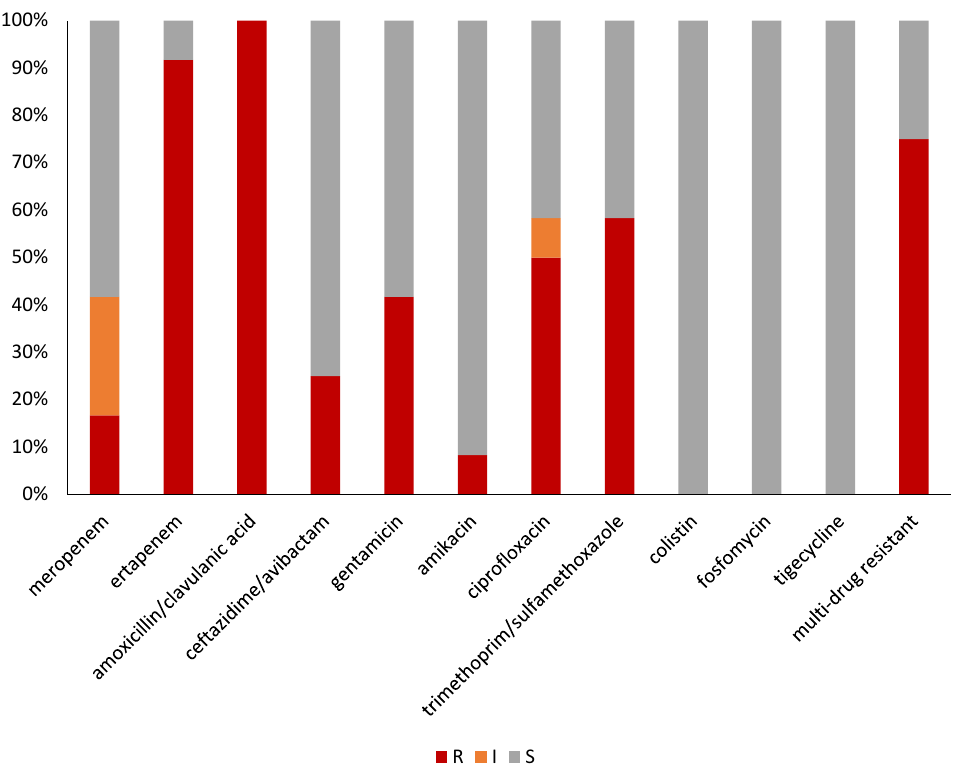
Figure 1. Antimicrobial susceptibility profiles of 12 CP- E. coli isolates from intestinal carriage in elderly patients. Red/orange/grey color in each column indicates percentage of resistant/susceptible, increased exposure/susceptible isolates, respectively.